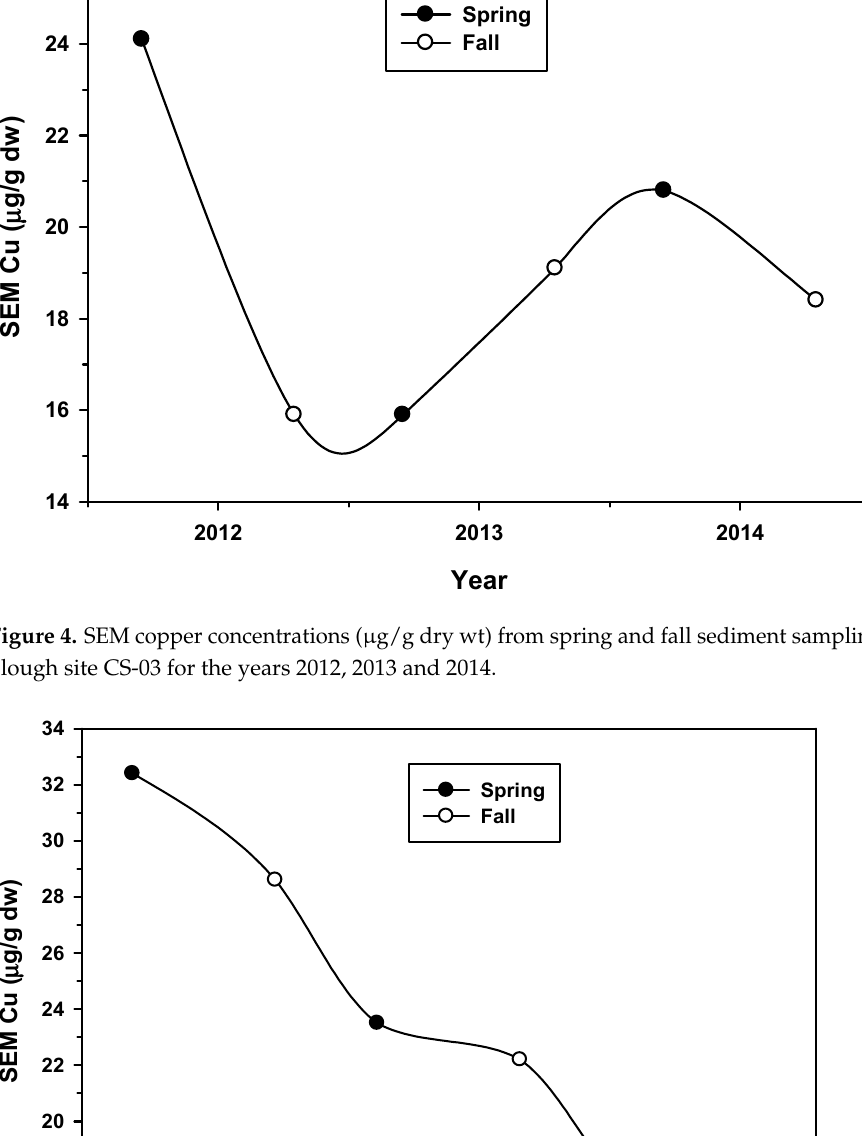
Figure 3. SEM copper concentrations (µg/g dry wt) from spring and fall sediment sampling at Cache Slough site CS-02 for the years 2012, 2013 and 2014.